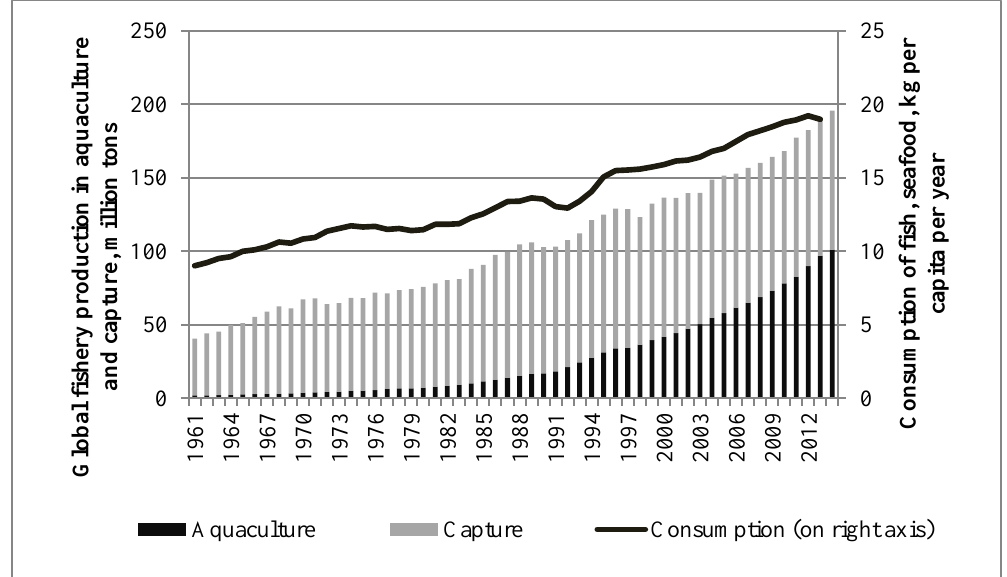
Fig. 2. Global fishery production, 1961−2014. (Developed by author; FAO data,